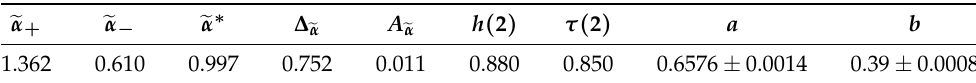
Table 1. Multifractal indices reported for the BPd signal and estimated parameters of the multiplica- tive